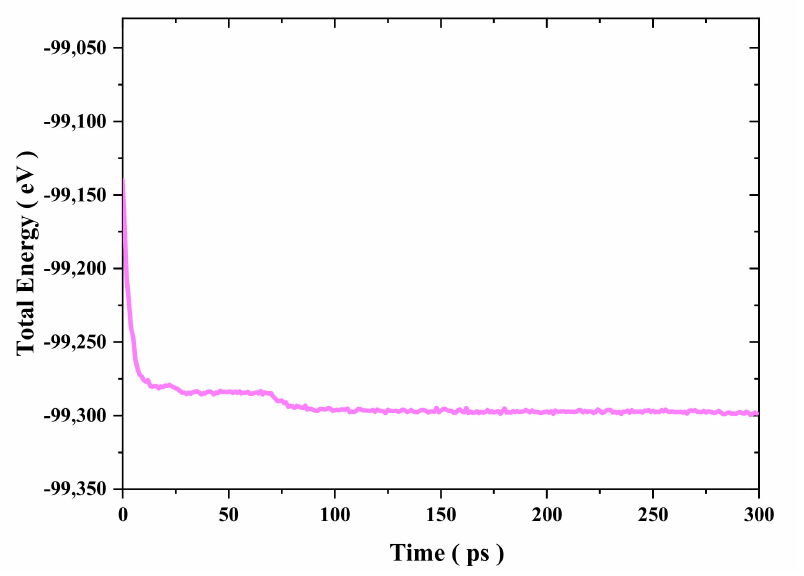
Figure 1. Copper nanocones surface bonding simulation model.